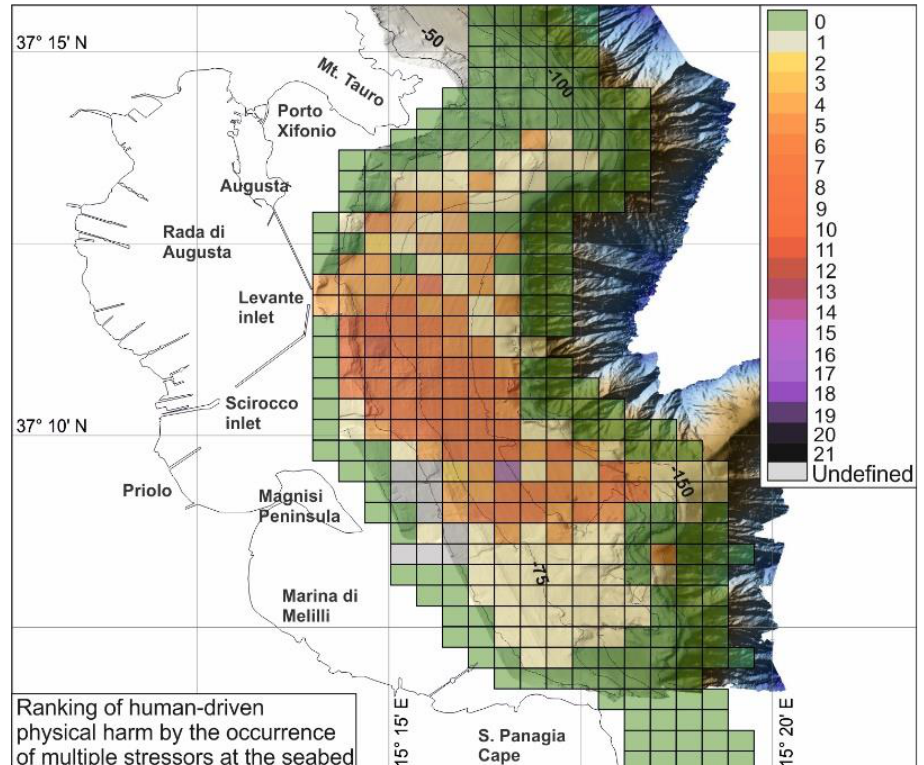
Figure 7. Synoptic map of Augusta Bay, reporting a semi-quantitative estimate of physical harm at seabed.